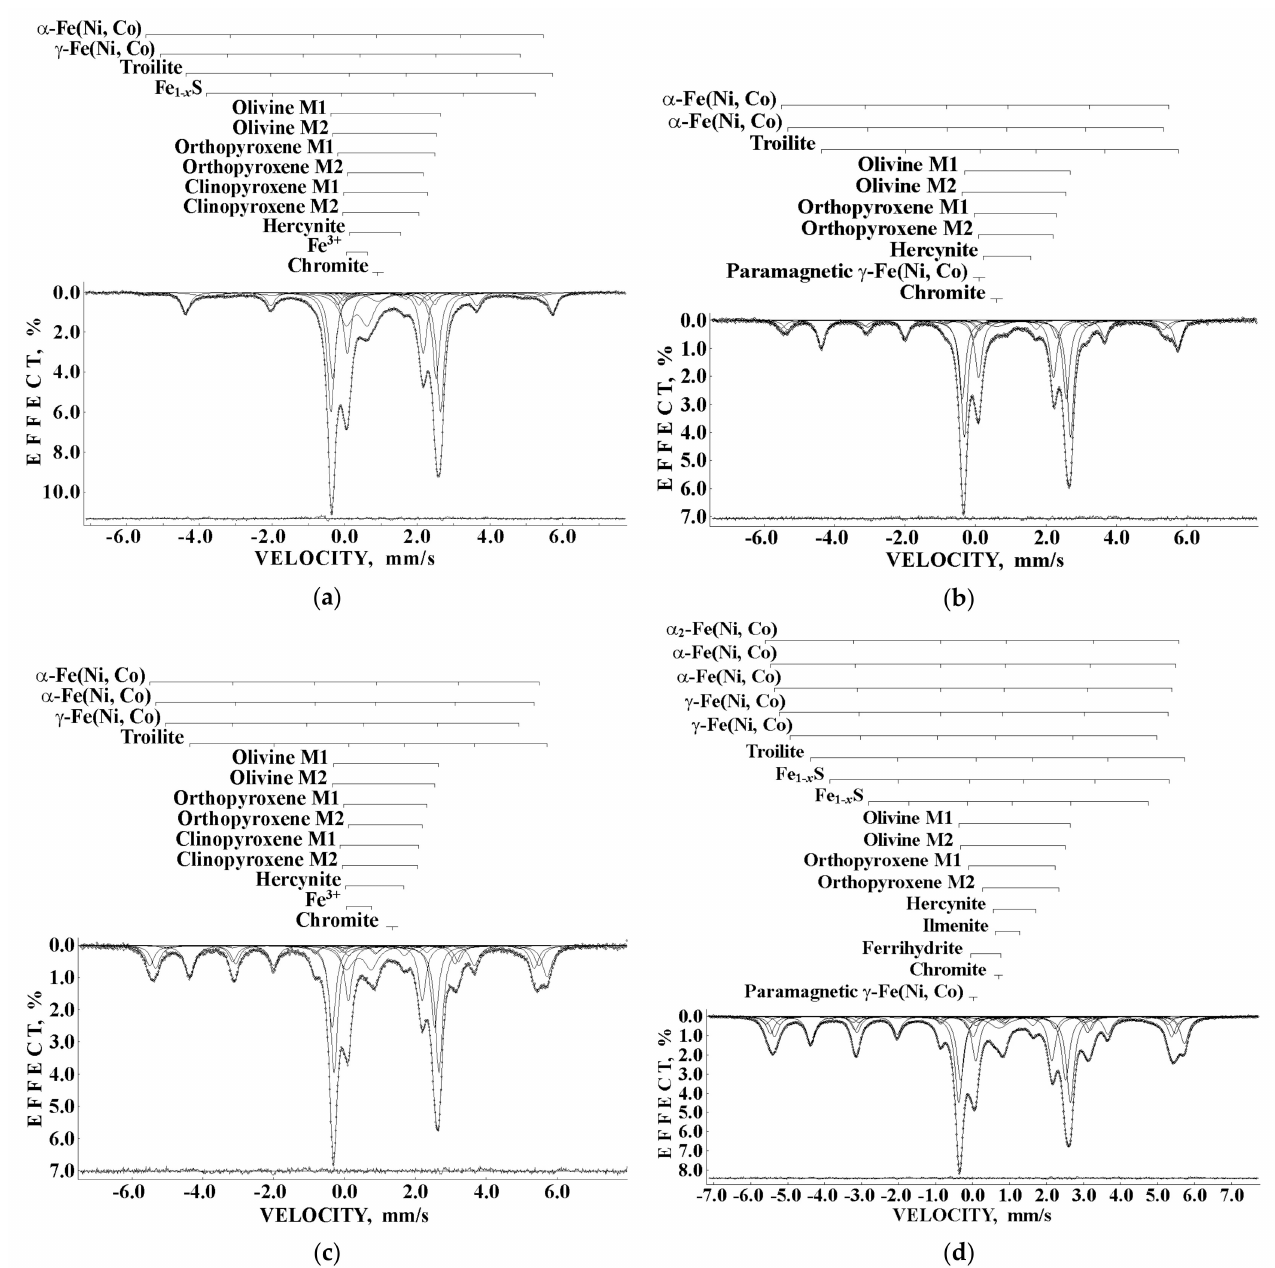
Figure 29. Room temperature Mössbauer spectra of equilibrated ordinary chondrites Tsarev L5 (a new sample) [98] ( a ), Ozerki L6 [99] ( b ), Kemer L4 [100] ( c ) and Bursa L6 [101] ( d ). Indicated components are the results of the best fits. The differential spectra are shown on the bottom. Adapted from References